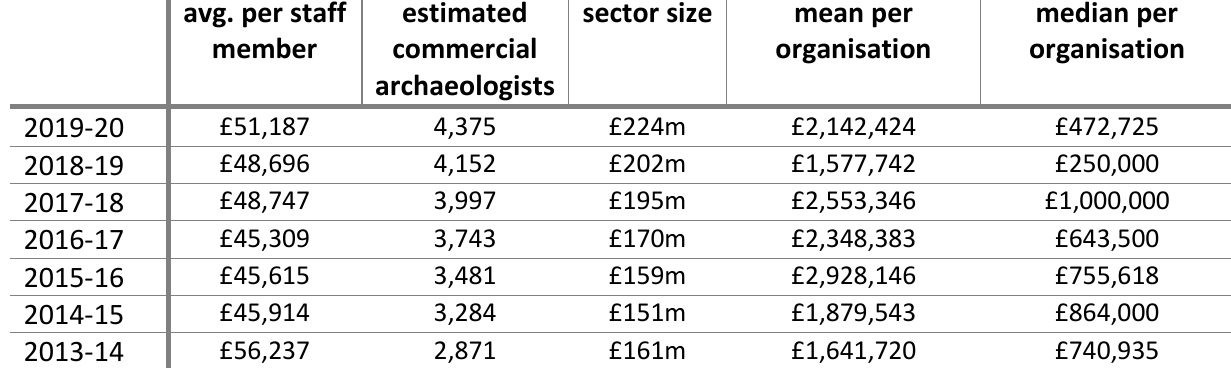
Table 12: The average turnover per employee, estimated number of archaeologists, total value of the commercial archaeology sector, mean turnover per respondent and median turnover per respondent from 2014 to 2020. UK